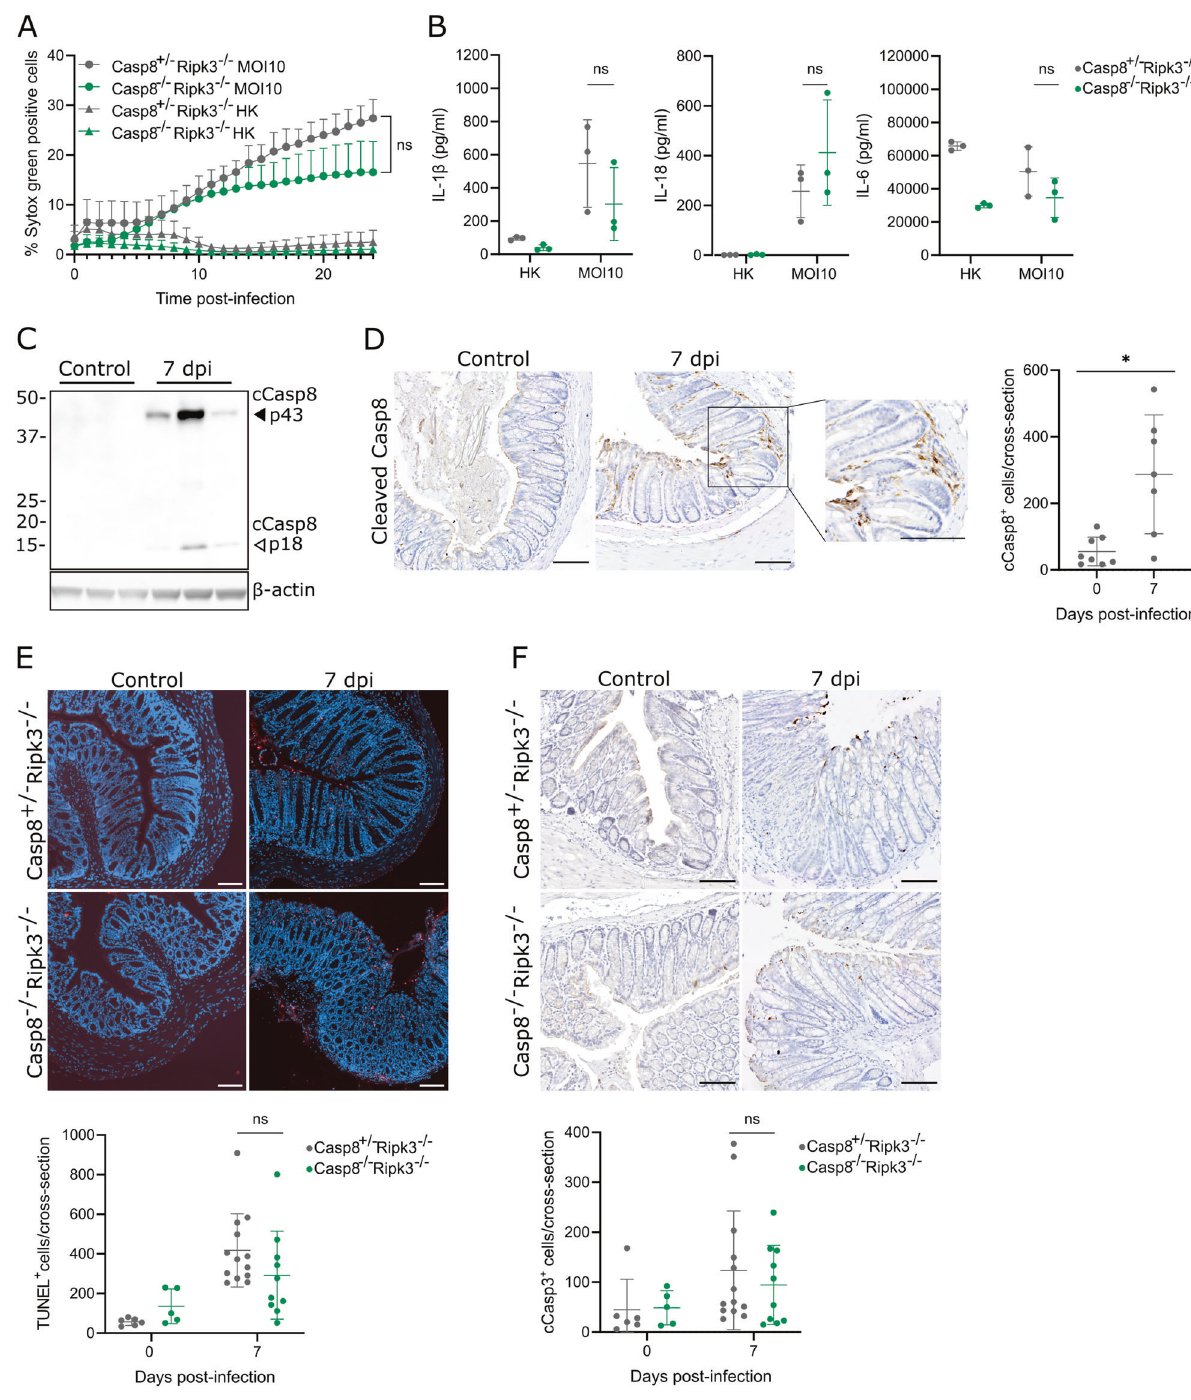
Fig. 5 C. rodentium induces caspase-8-independent cell death in cultured macrophages, while C. rodentium infected mice display cCasp3- associated but caspase-8-independent colonic cell death. A Realtime cell membrane permeability analyses of Casp8 + /- Ripk3 – / – and Casp8 – / – Ripk3 – / – BMDMs either infected with live C. rodentium (MOI 10) or provided with equal amounts of heat-killed (HK) C. rodentium . Data are means + SD of biological triplicates. B IL-1 β , IL-18, and IL-6 measurements in culture supernatant of Casp8 + /- Ripk3 – / – and Casp8 – / – Ripk3 – / – BMDMs either infected with live C. rodentium (MOI 10) or provided with equal amounts of heat-killed (HK) C. rodentium for 24 h. Data are means ± SD of biological triplicates. C Western blot analyses on whole colon lysates from WT mice not infected or infected with 5 × 10 9 CFU C. rodentium for 7 days. Every lane represents a whole colon lysate from a different mouse. D Representative cCasp8 IHC staining on colons from WT mice not infected or infected with 5 × 10 9 CFU C. rodentium for 7 days. Magni fi cation shows area with both epithelial and non-epithelial cCasp8 + cells. Scale bars 100 µm. Representative colon ( E ) TUNEL and ( F ) cCasp3 stainings and respective quanti fi cations from Casp8 + /- Ripk3 – / – and Casp8 – / – Ripk3 – / – littermates not infected or infected with 5 × 10 9 CFU C. rodentium for 7 days. Every data point in the quanti fi cation represents a different mouse with means ± SD, n = 5-13 per group. Scale bars 100